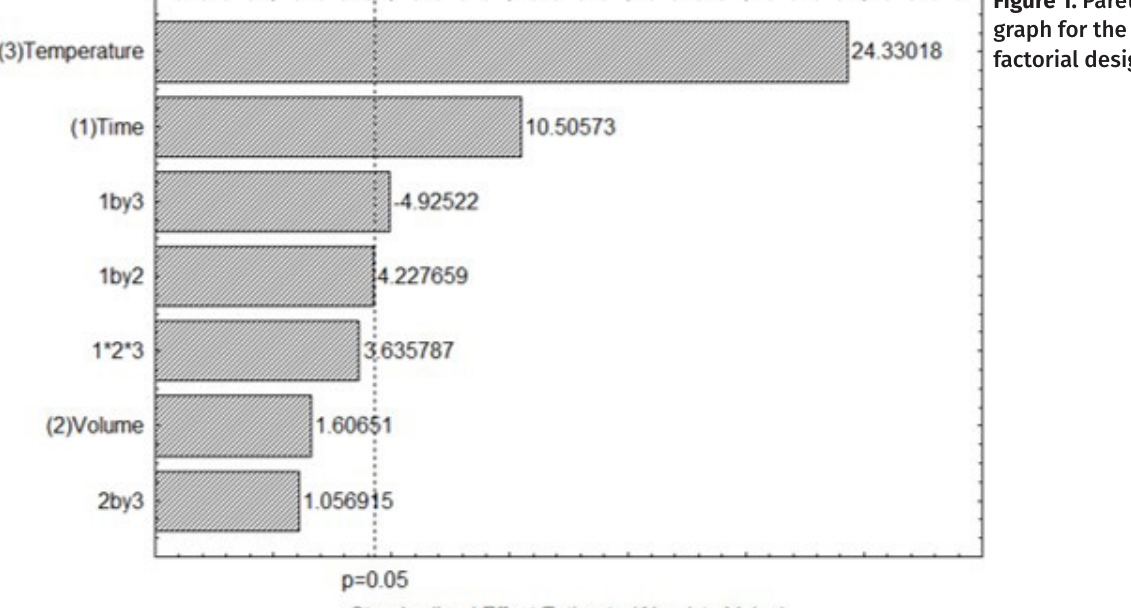
Figure 1. Pareto graph for the 2 3 factorial